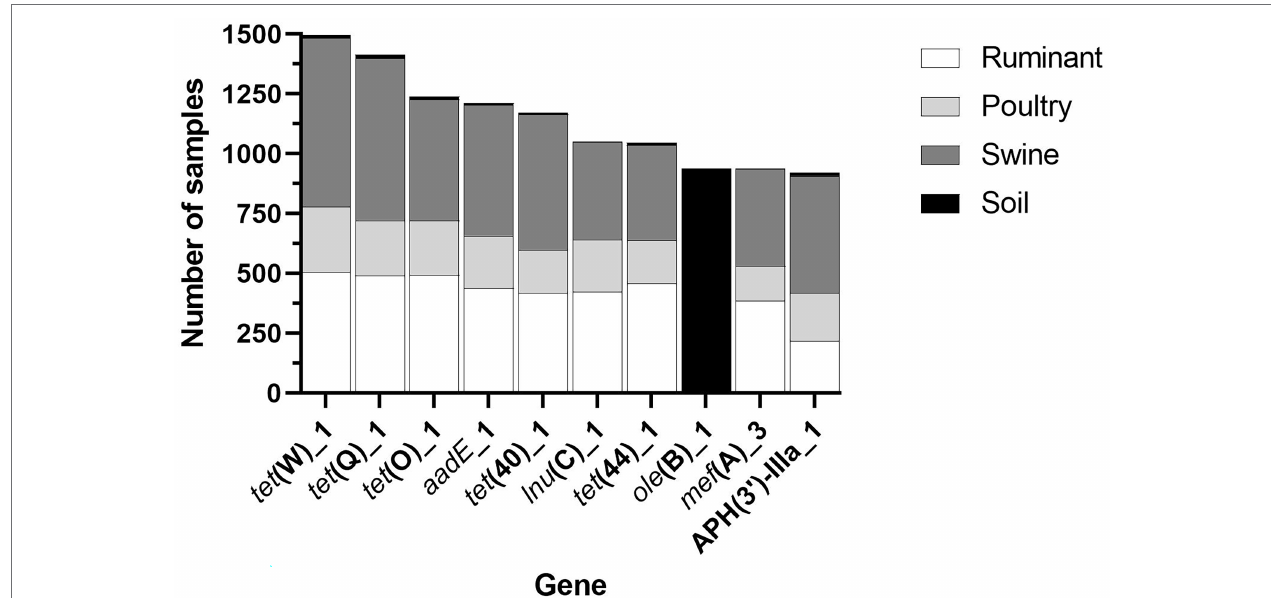
FIGURE 5 | The most widespread resistance genes across all the four microbiome